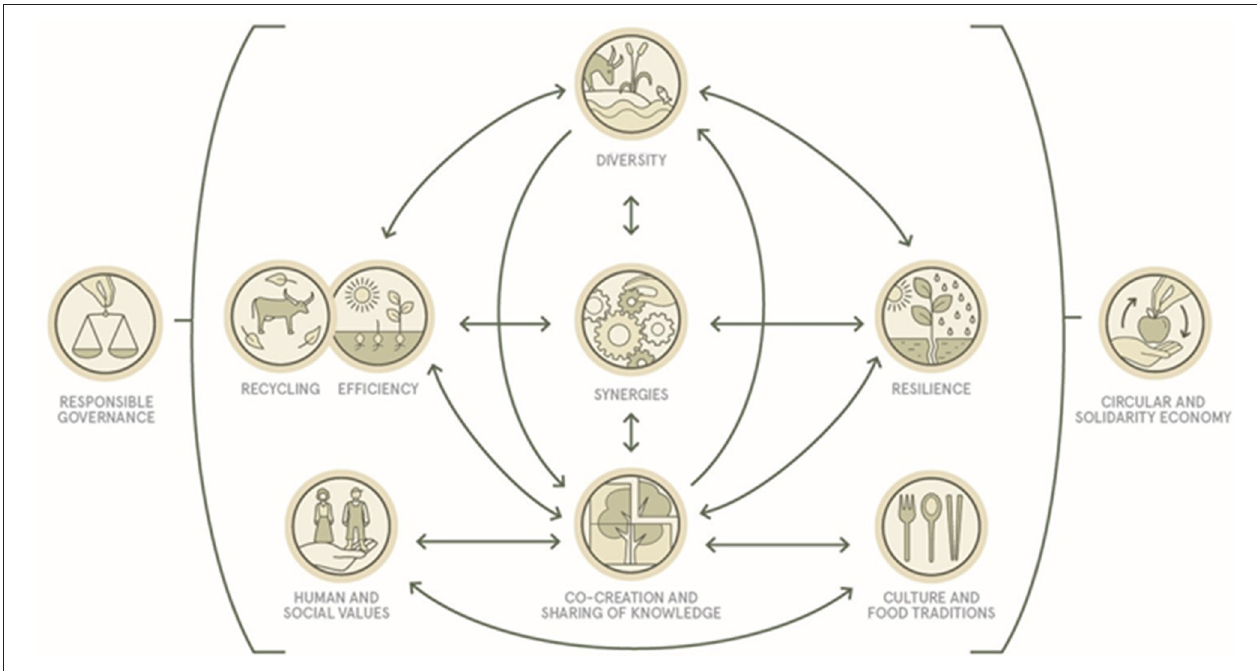
FIGURE 2 | The 10 Elements of Agroecology (FAO, 2018a).